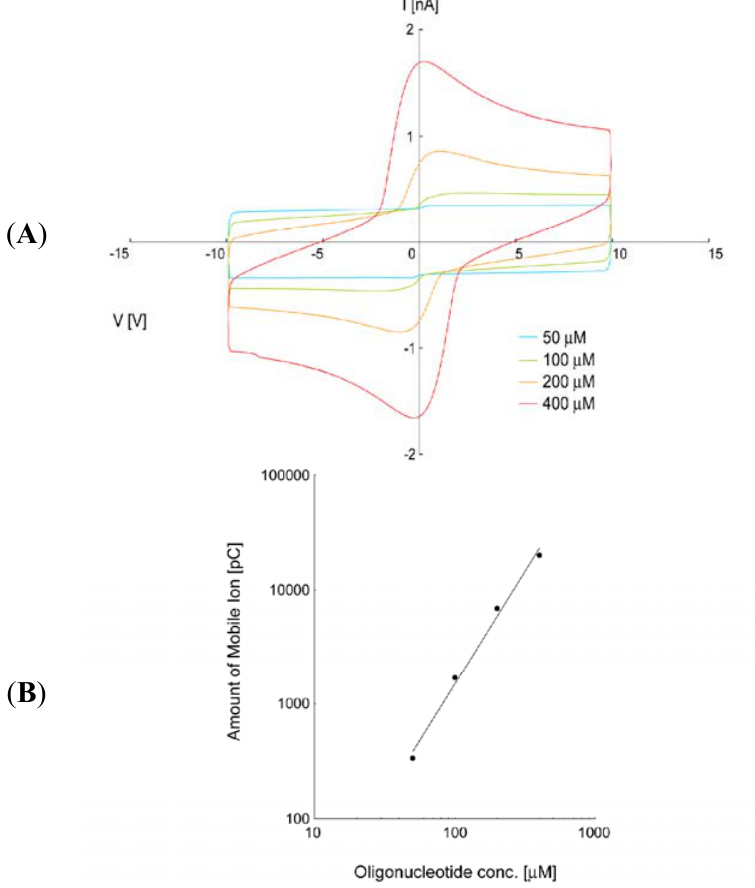
Figure 6. Concentration characteristics of LC cells doped with G10b. ( A ) Each line represents the I-V curve of the LC cell doped with G10b at different concentrations; red line: 400 μ M, orange line: 200 μ M: green line: 100 μ M, and blue line: 50 μ M. ( B ) Shows the relationship between concentration of G10b and ion density of LC cells, calculated from the peak at positive voltage application. The horizontal and vertical axes of our measurement results are concentration of G10b in LC cells and ion density of LC cells,